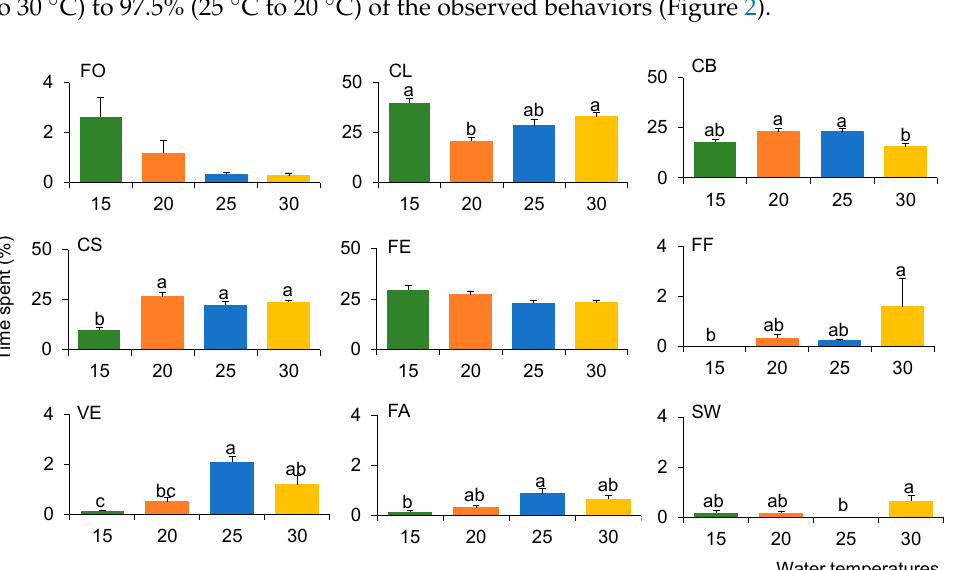
Figure 2. Average proportion of time spent by apple snails on each of the nine types of behaviors under different water temperature change regimes for two days. Different letters indicate significant differences among temperature conditions based on Dunn’s multiple comparison test ( p < 0.05). Error bars indicate standard error of each behavior. We used 432 numbers using 10 min internal data for each individual. Error bars present the standard errors. FO: floating, CL: clinging to the side of the aquarium, CS: crawling on the side of the aquarium, CB: crawling on the bottom of the aquarium, FE: feeding, FF: folding a funnel with its food, VE: ventilating the lung, FA: falling, and SW: swimming.